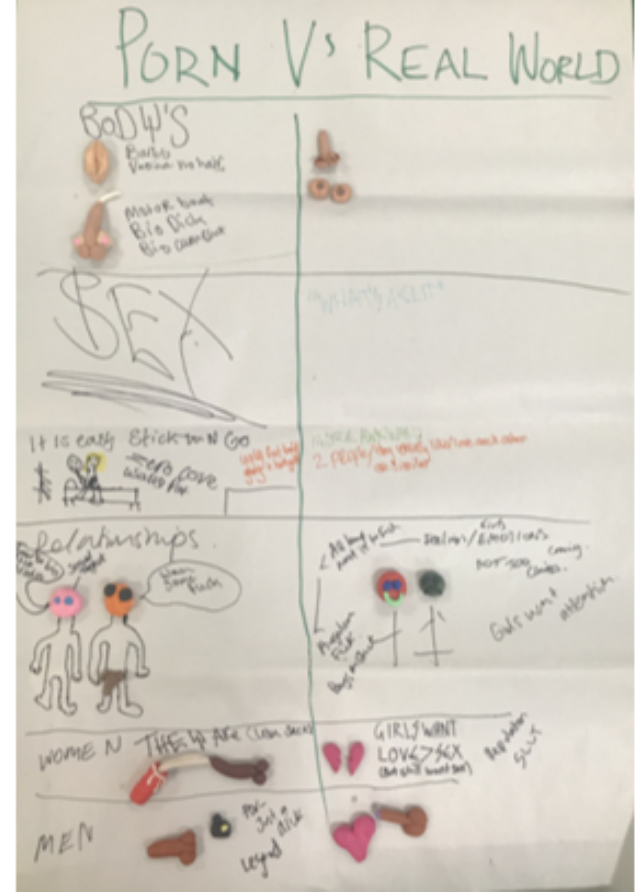
Figure 2. Porn world vs. real world activity